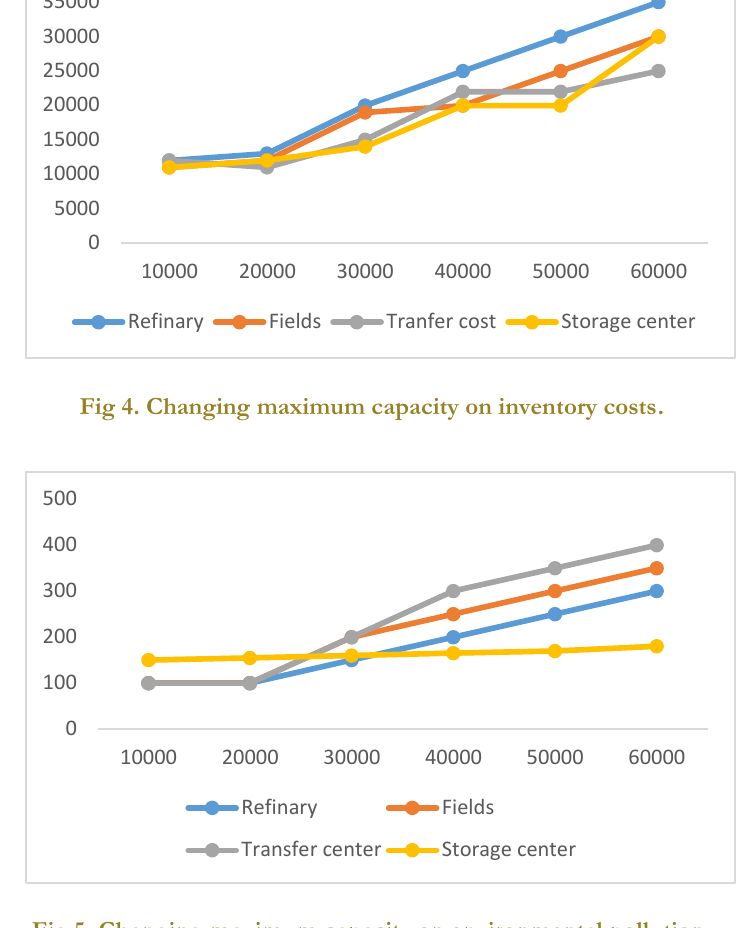
Fig 5. Changing maximum capacity on environmental